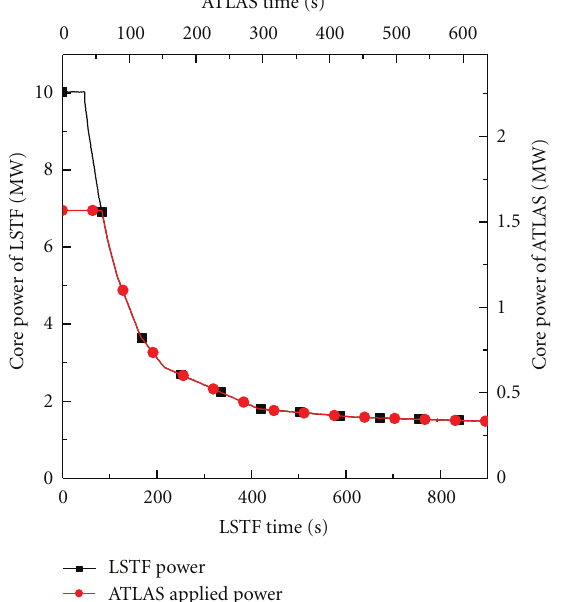
Figure 20: Comparison of the applied power in the LSTF counter- part test.